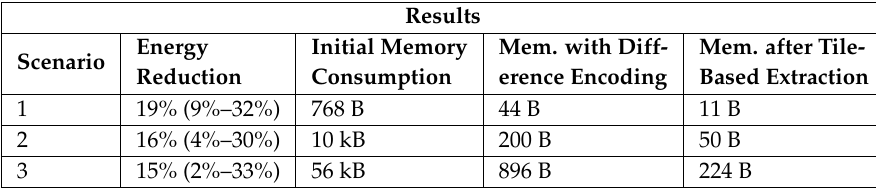
Table 5. Memory usage in different